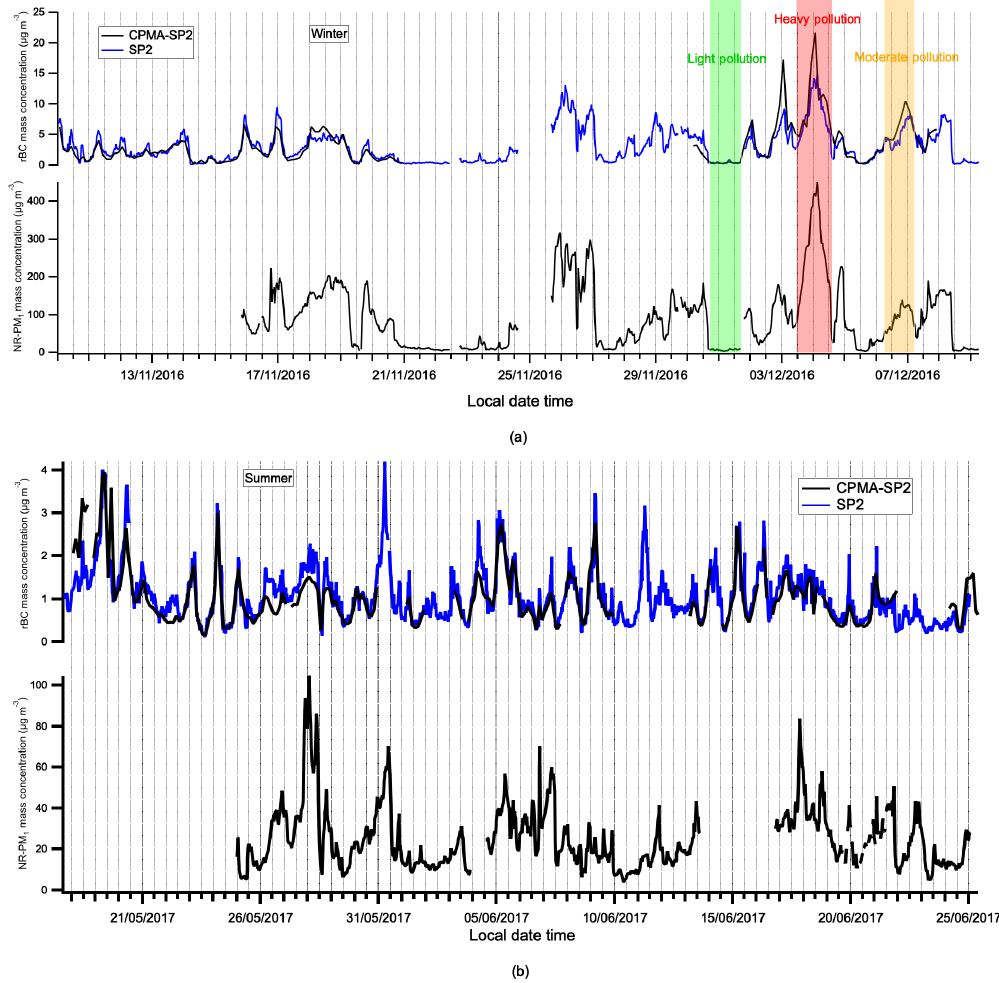
Figure 3. Time series of rBC mass concentration and NR-PM 1 concentration for the winter (a) and summer (b)